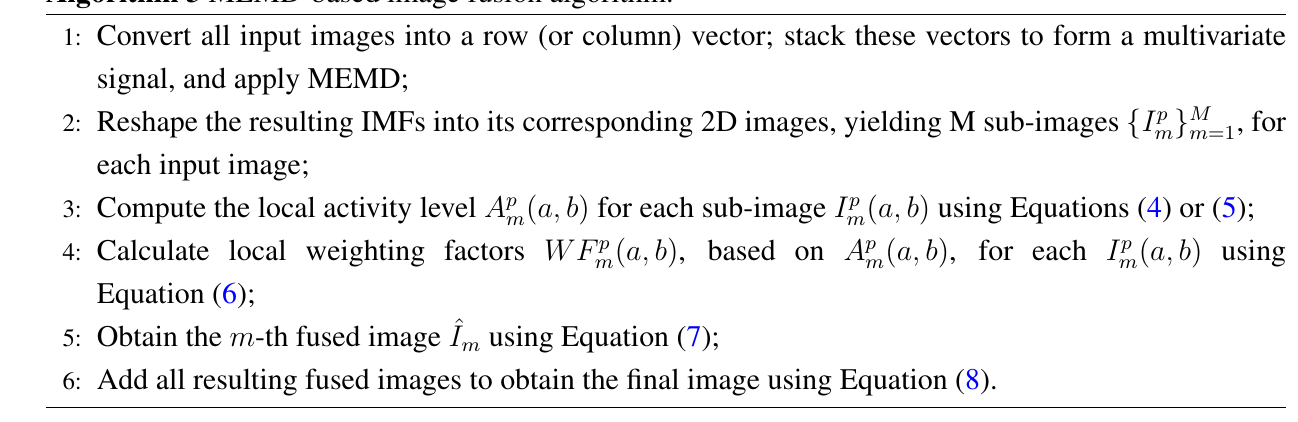
Figure 6. The proposed scheme illustrating the local fusion of P arbitrary images, which yields a single fused image ˆ I , using the MEMD algorithm. Algorithm 3 MEMD-based image fusion